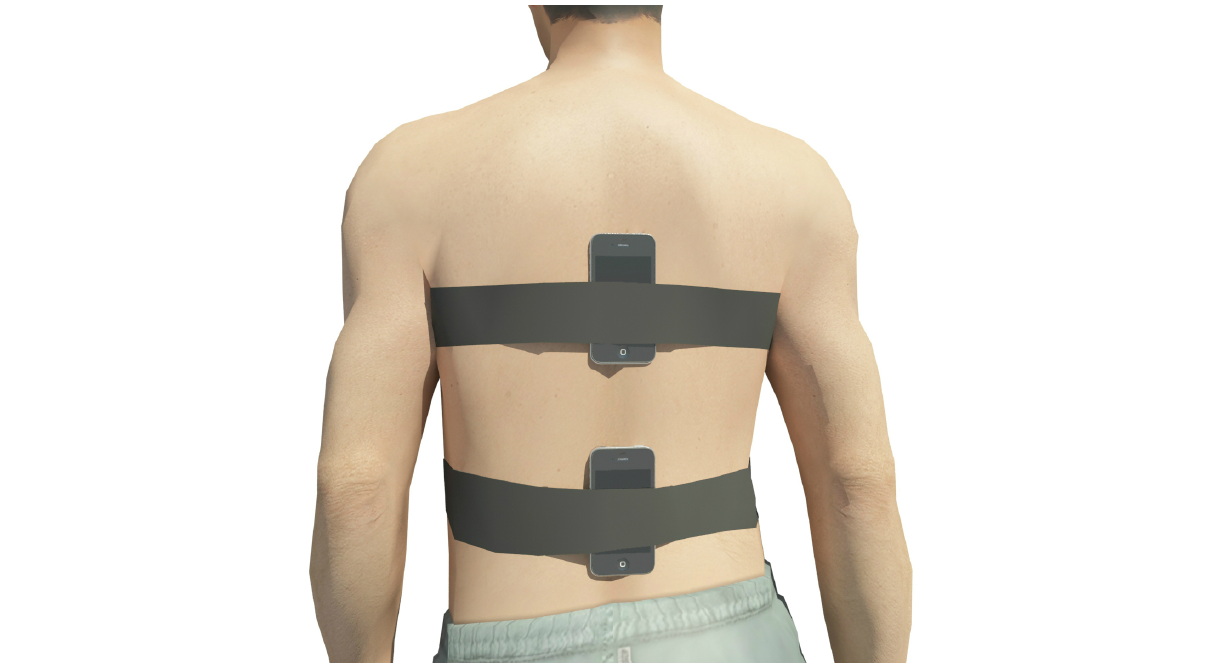
Figure 2. Position of the inertial sensors on the back of